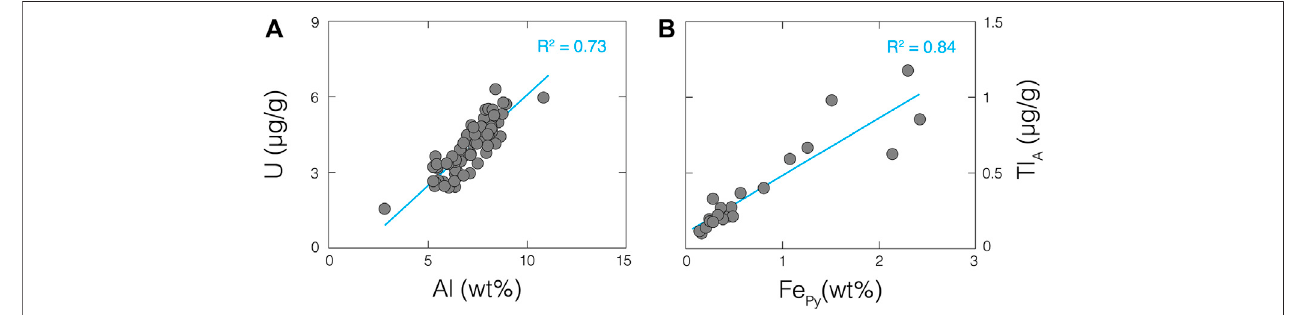
FIGURE 7 | A strong linear correlation between bulk-shale U and Al concentrations (A) suggests a shared detrital origin, while an even stronger linear correlation between leached Tl and pyrite Fe concentrations (B) suggests a strong Tl-pyrite connection. Aluminum and pyrite Fe data are from Ostrander et al. (2020). Linear trendlines are provided in blue, along with corresponding R 2 values.